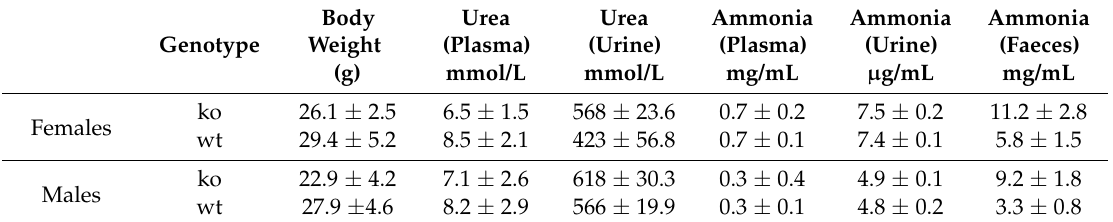
Table 1. Body weight, urea levels in plasma and urine of SLC6A19ko and SLC6A19wt Mice. Genotype